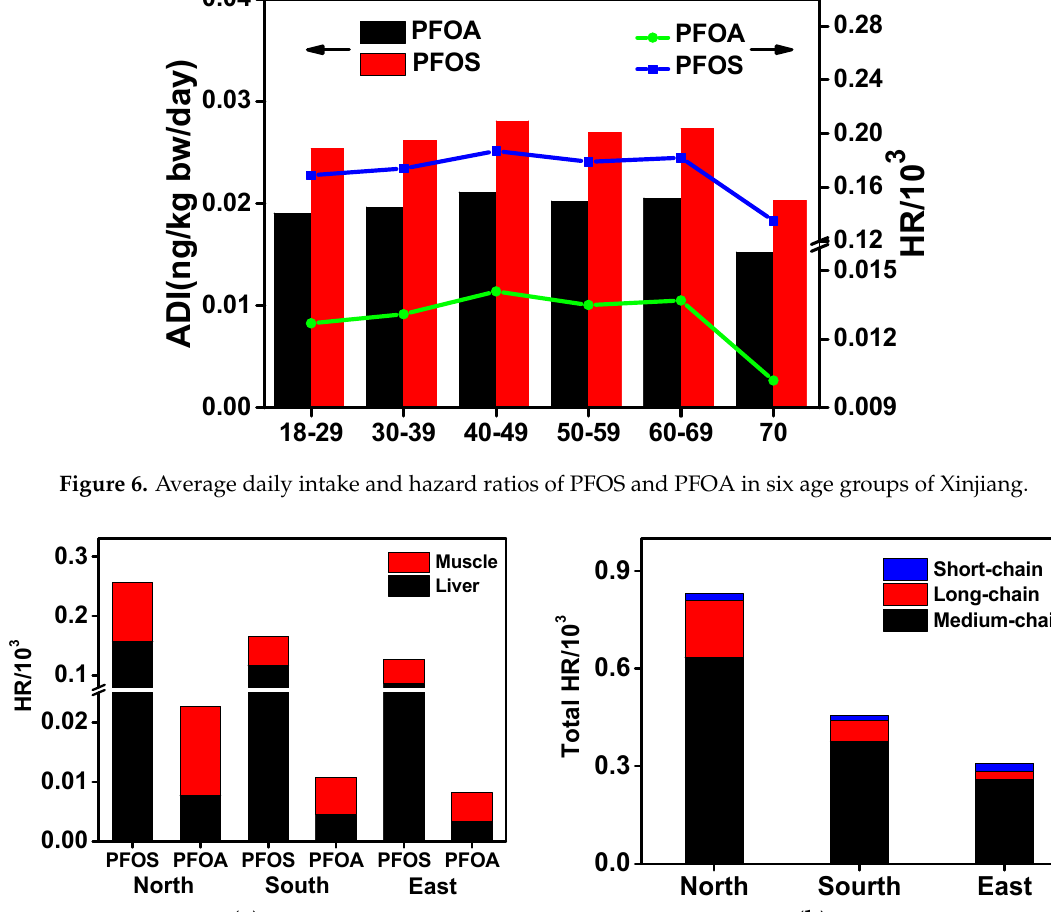
PFOS PFOA PFOS PFOA PFOS PFOA